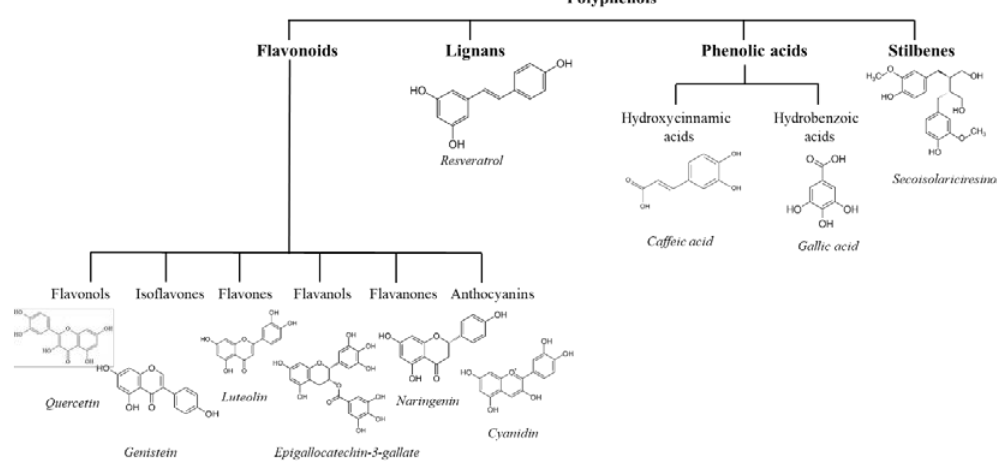
Figure 1. Chemical structures and classification of polyphenols.